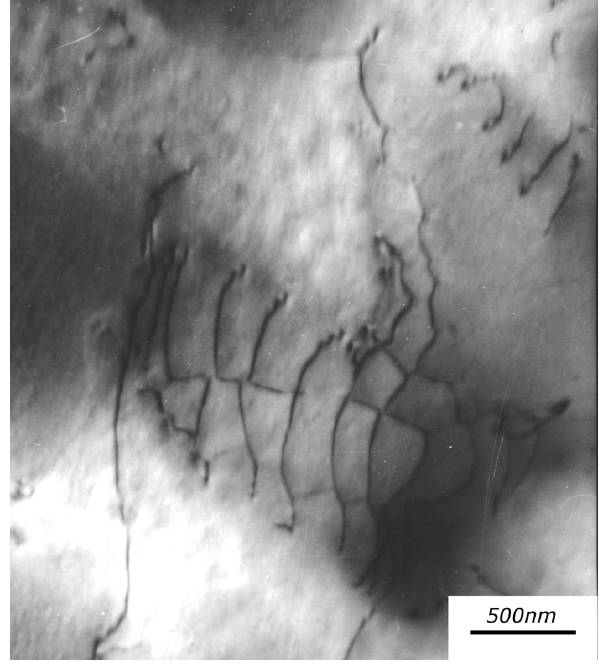
Figure 5. TEM micrograph displaying the evolution of a network of dislocations in a PFZ after two MS test runs.